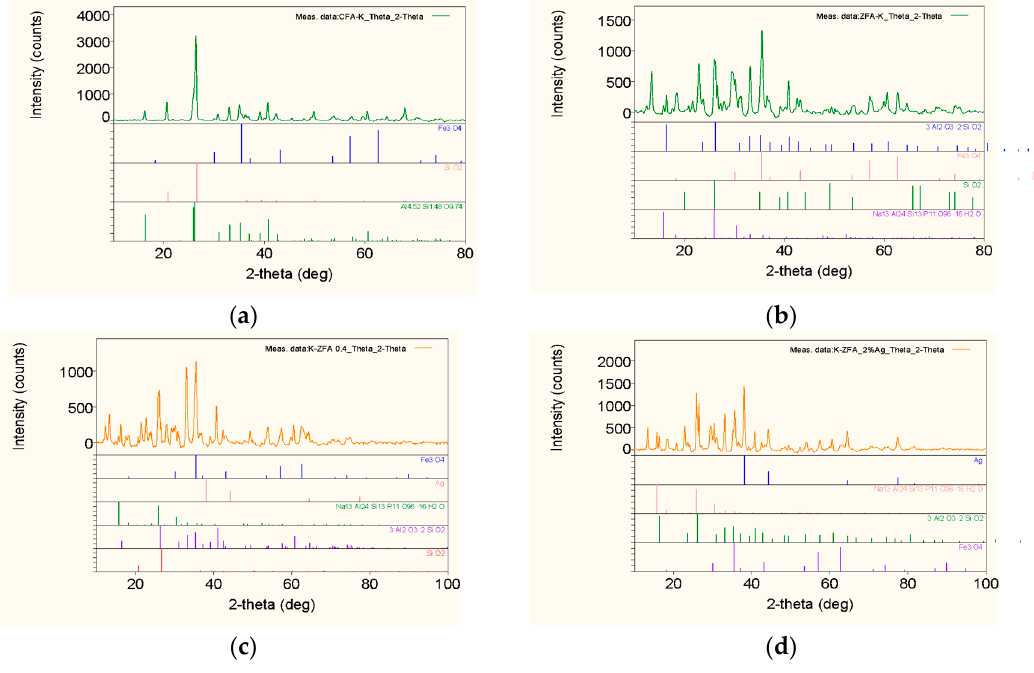
Figure 1. XRD spectra of raw and produced materials: ( a ) K-CFA; ( b ) K-ZFA; ( c ) 0.34 wt.%-Ag-K-ZFA; ( d ) 4.71